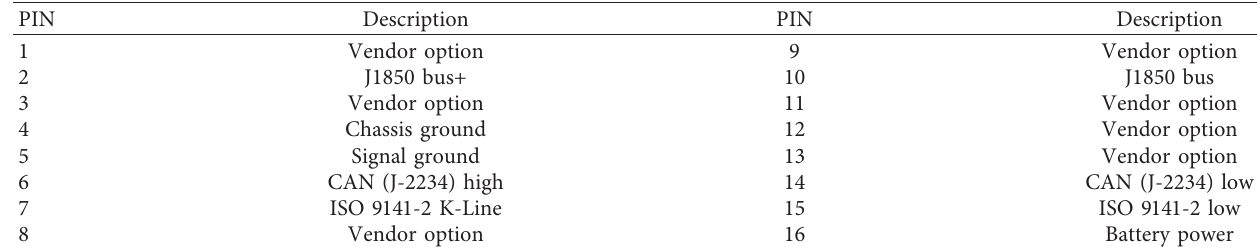
Figure 1: OBD-II male and female connectors. Table 1: OBD-II standard pins description.